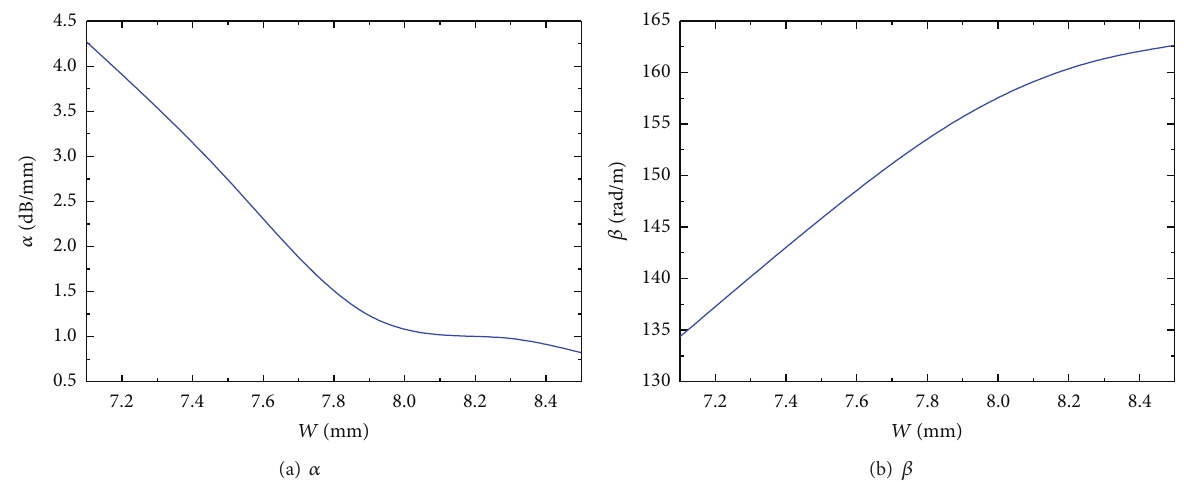
Figure 3: Variations of leakage constant and propagation constant as functions of 𝑊 .